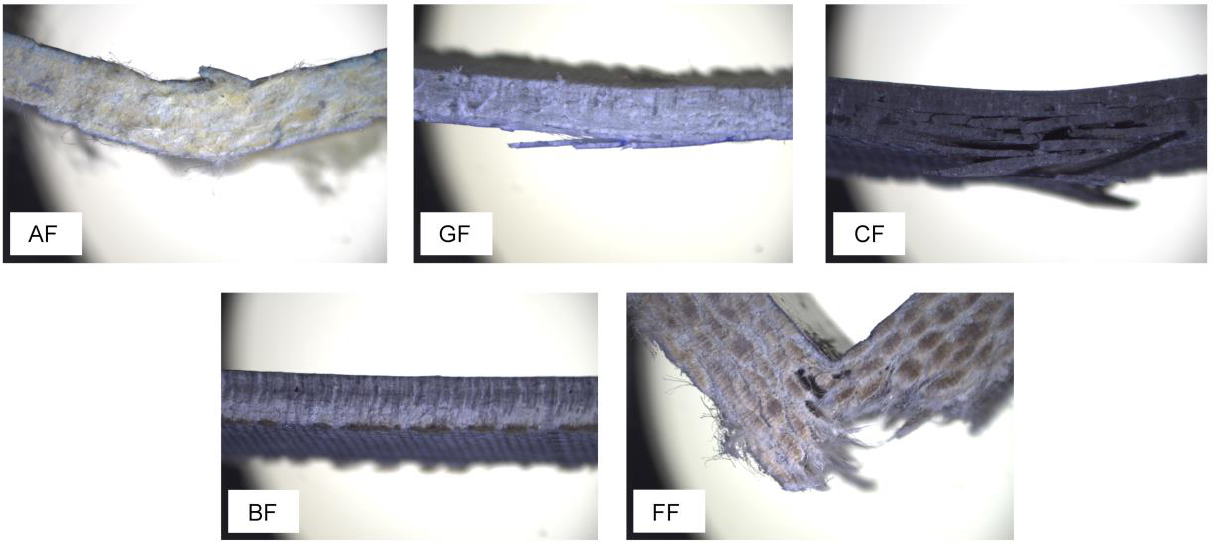
Figure 11. Profile view of the samples after Charpy impact test by an optical microscope.